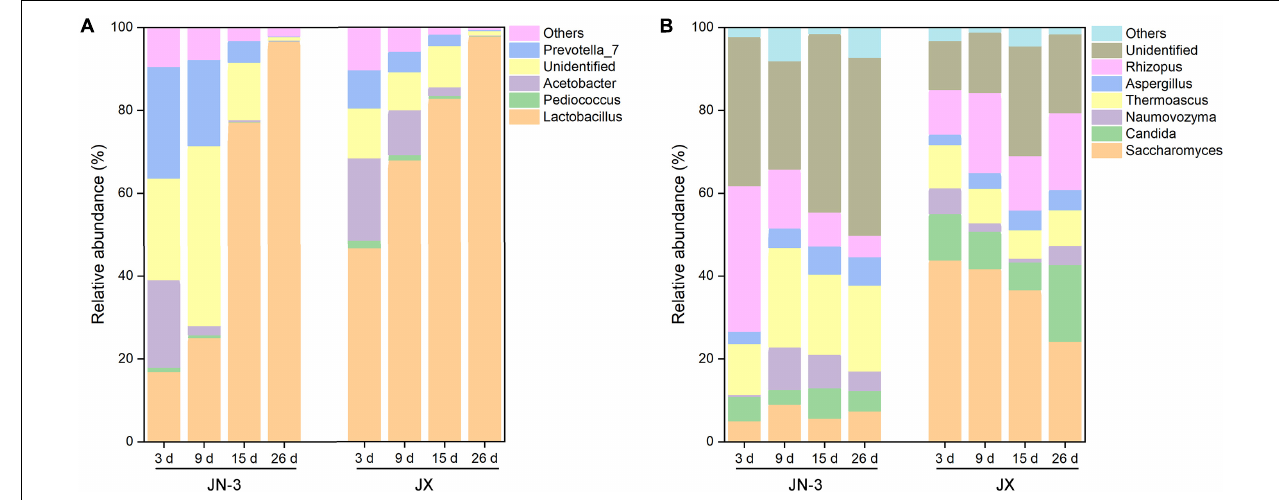
FIGURE 4 | Changes in bacterial (A) and fungal (B) taxonomic composition of fermented grains at the genus level in one waxy (JN-3) and one non-waxy sorghum (JX). The abundance of each taxon was calculated as the percentage of sequences per gradient for a given microbial group. The taxa represented the class that occurred over 1% abundance in at least one type of